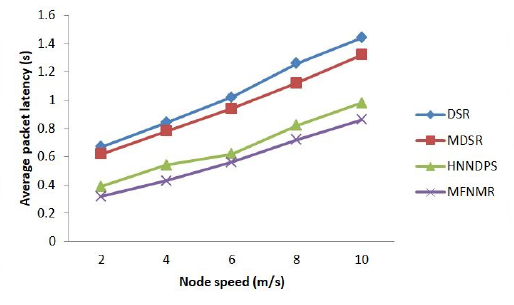
Figure 9. Average Packet Latency Analysis based on Node Speed.